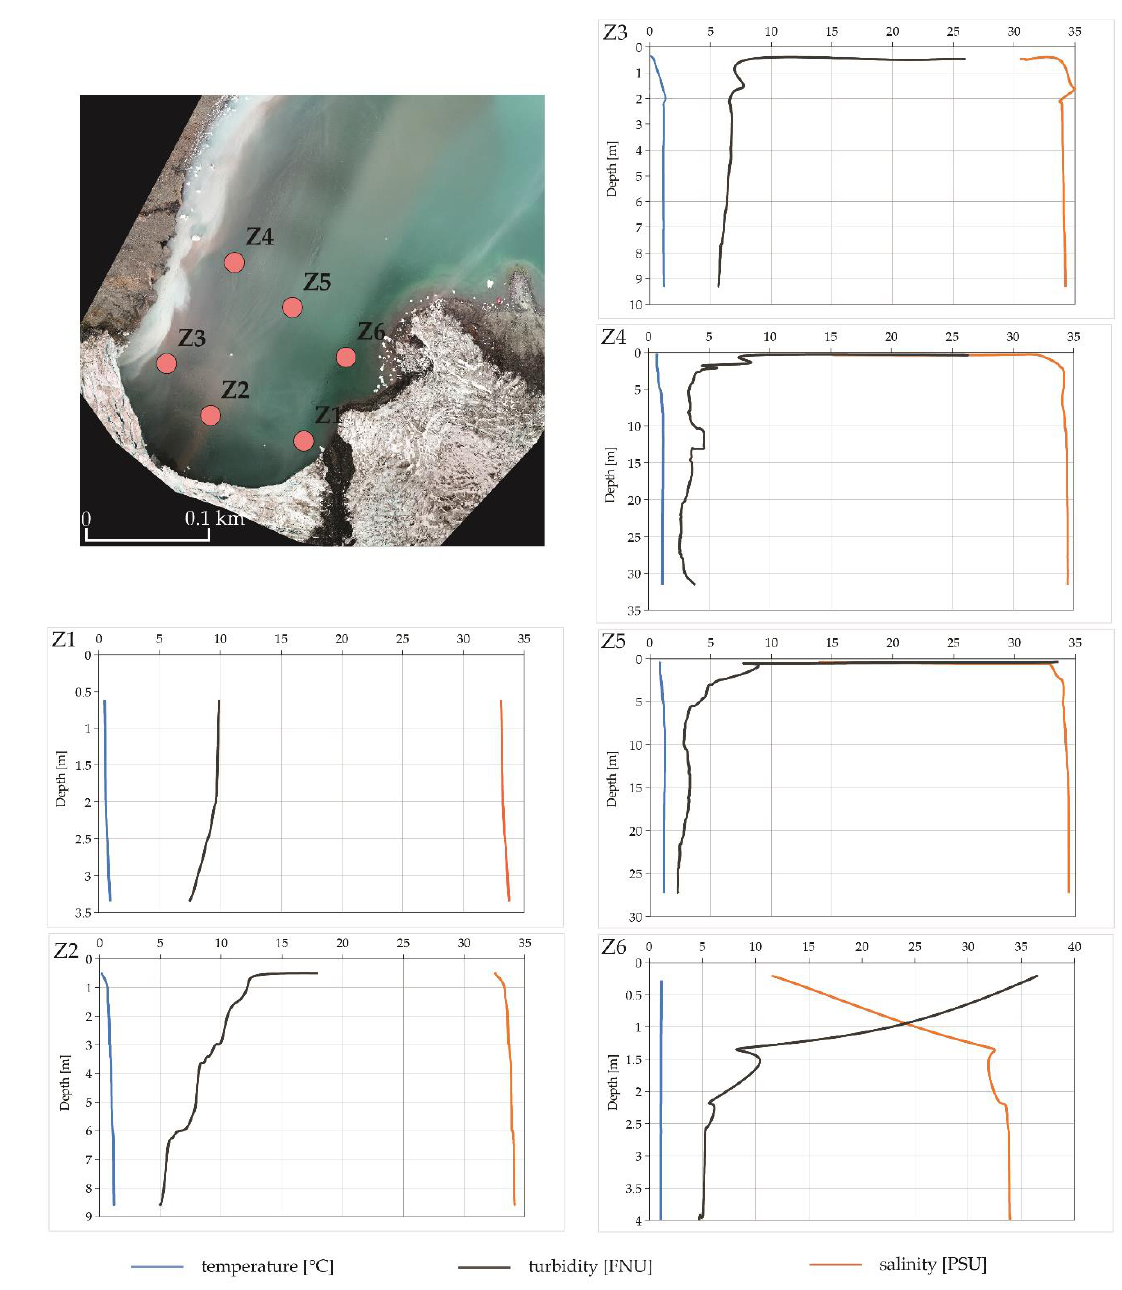
Figure 4. Vertical distributions of water temperature, turbidity, and salinity in front of the Zalewski Glacier on 15 February, 2019.